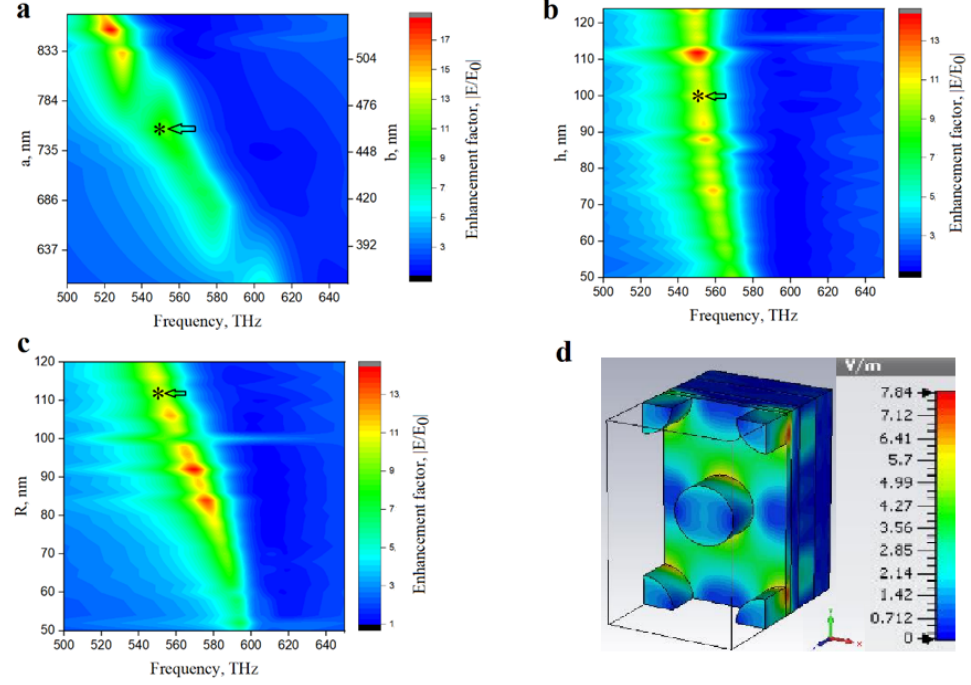
Figure 3. Enhancement factor as a function of: ( a ) unit cell width; ( a , b ) cylinder height h; ( c ) cylindrical radius R; ( d ) amplitude of the E-field on the surface of the unit cell illuminated by a plane wave with the amplitude 1 V/m and TE ‐ polarization. The combination of geometric parameters and the frequency corresponding to this E—field distribution is marked by a star with an arrow in ( a – c ).